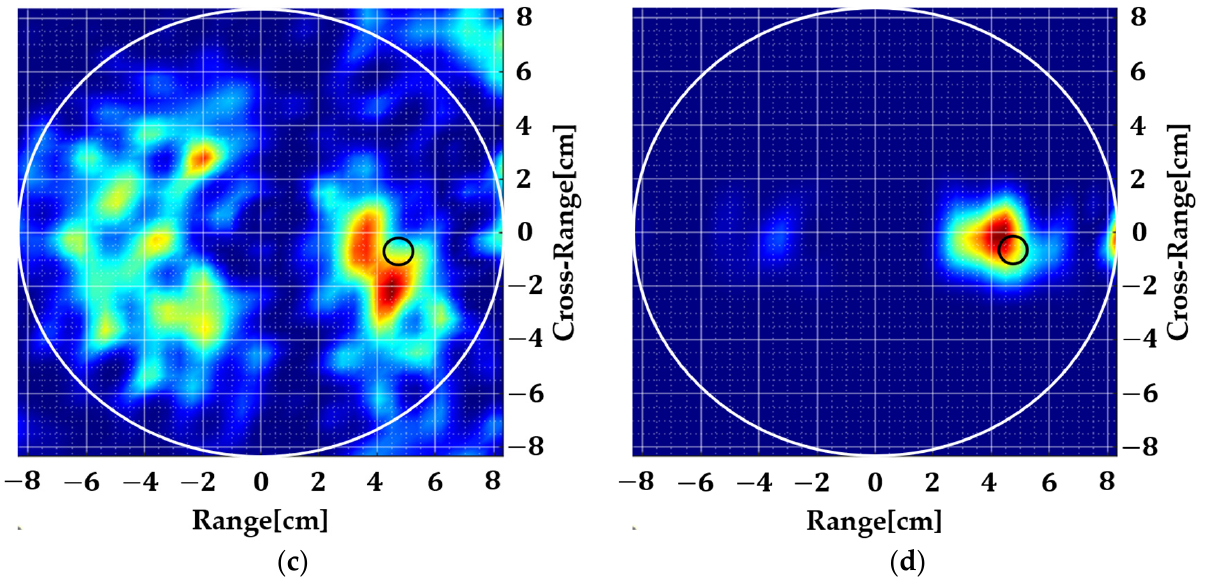
Figure 15. Measured results with an inhomogeneous background. The small black circle shows the true target location where background contains: ( a , b ) 10% inhomogeneity, ( c , d ) 20% inhomogeneity.